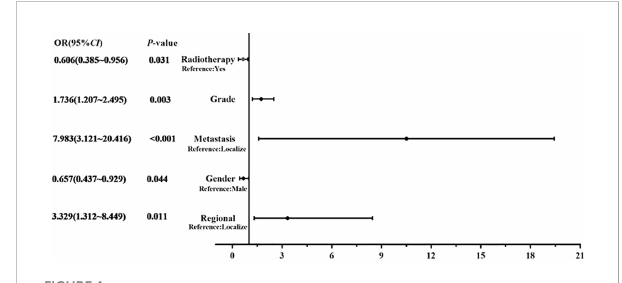
FIGURE 1 Forest map showing the independent risk factors of DDS in spinal osteosarcoma